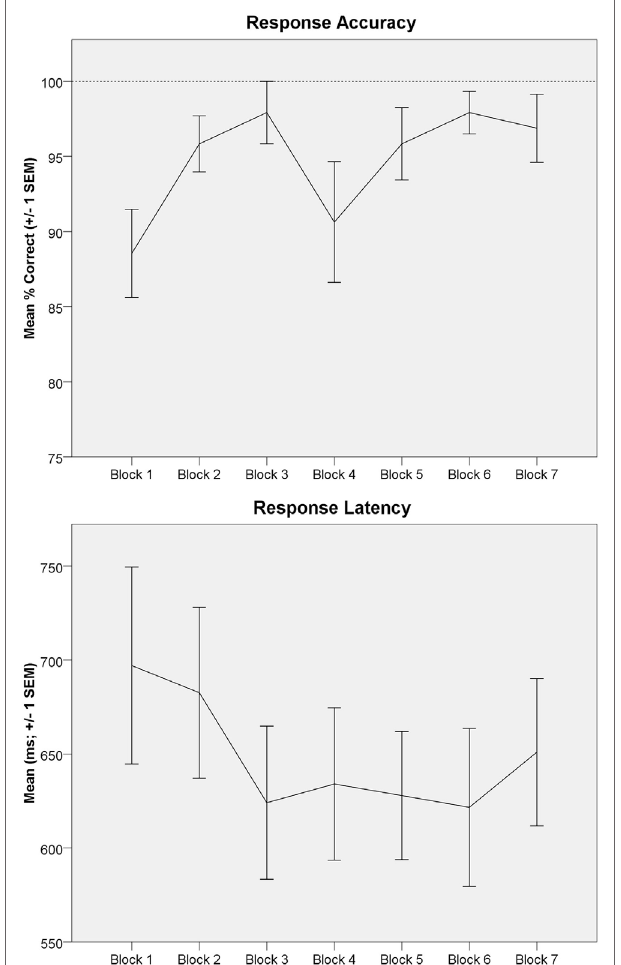
FigUre 4 | Letter 2-back behavioral data are depicted. Upper panel: letter 2-back response accuracy (mean percentage correct ± 1 SEM) is depicted across task blocks. Response accuracy significantly improved across task repetitions (Time effect). Lower panel: letter 2-back response latency [mean response latency (ms) ± 1 SEM] is depicted across task blocks.